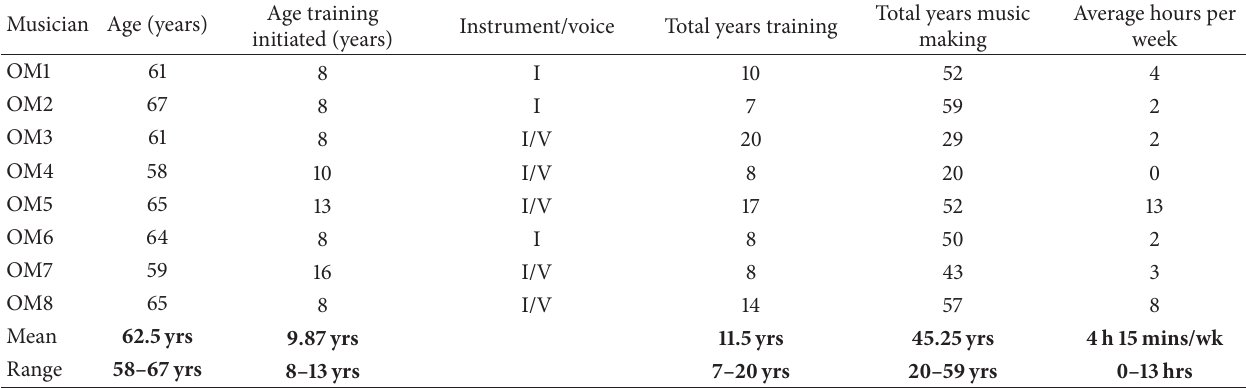
Table 1: Summary of older musician musical